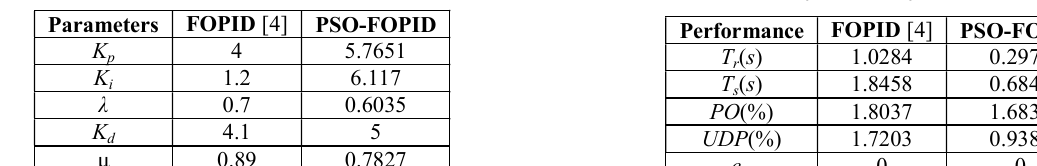
Table 4. Selected controller parameters